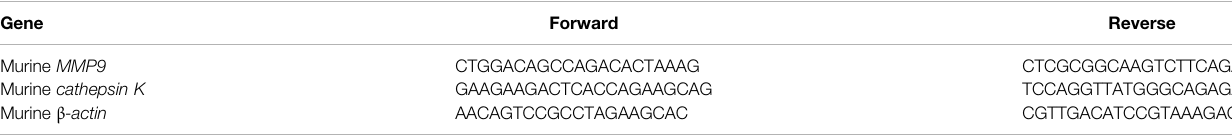
TABLE 1 | Primers used for real-time